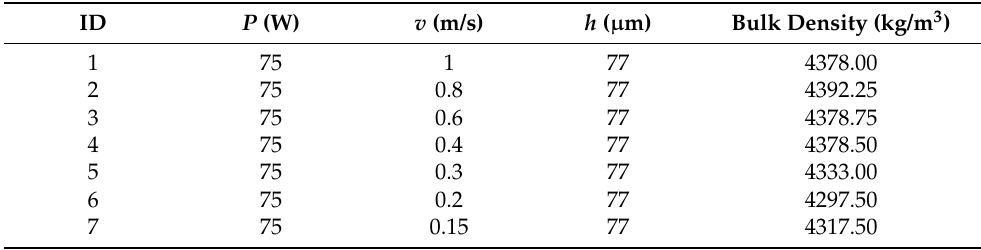
Table A13. Manufacturing parameters and experimental data adapted from [27]. Complement- ing relevant information and assumptions are the following; material: Ti6Al4V, heat conductivity κ = 6.4 W/mK and specific heat capacity C p = 546